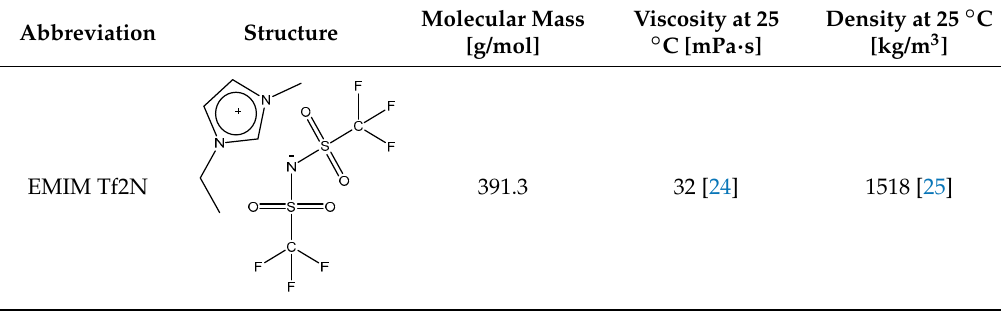
Table 1. Ionic liquid used in this study and its physical properties.